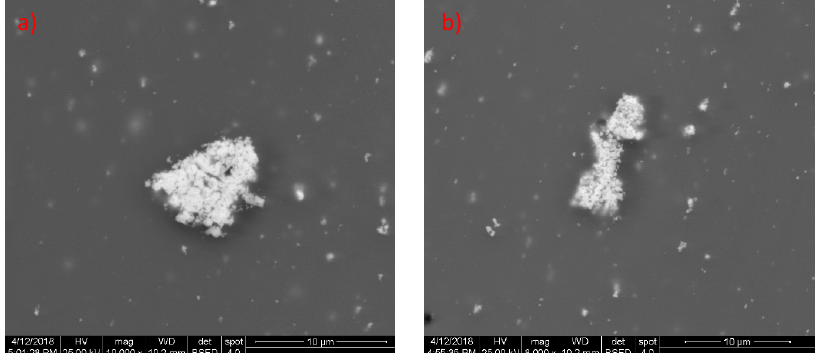
Figure 10. BSE images of the micrometric and sub-micrometric crystals detected in the glassy matrix, with ( a ) anhedral or ( b ) subhedral habitus (SSV_Y1 yellow sample from the monastery of San Severo in Classe, Ravenna, Italy—unpublished data).